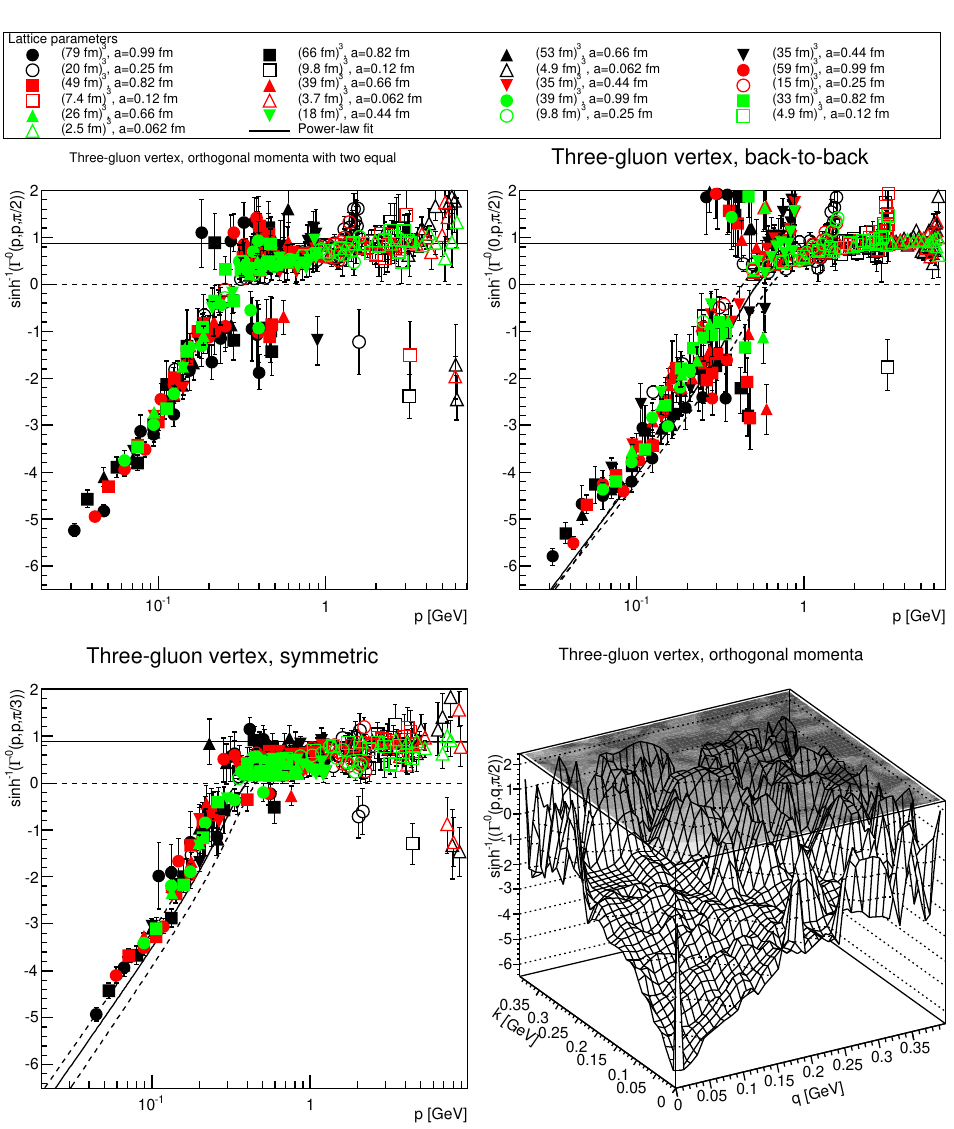
Figure 1: The three-gluon vertex tree-level form factor in three dimensions. The top- left panel shows a cut along the diagonal of the lower-right plot. The latter shows the situation with two momenta being orthogonal to each other, with interpolation of the data points for the largest volume at the coarsest discretization. The top-right panel shows the back-to-back momentum configuration and the bottom-left panel the symmetric momentum configuration. Only points with a relative error of less than 100% are shown, and the lowest momentum point is suppressed. The fit (4) shown is the extrapolated one in the symmetric configuration (bottom-left panel) and in the back-to-back configuration (top-right panel), see